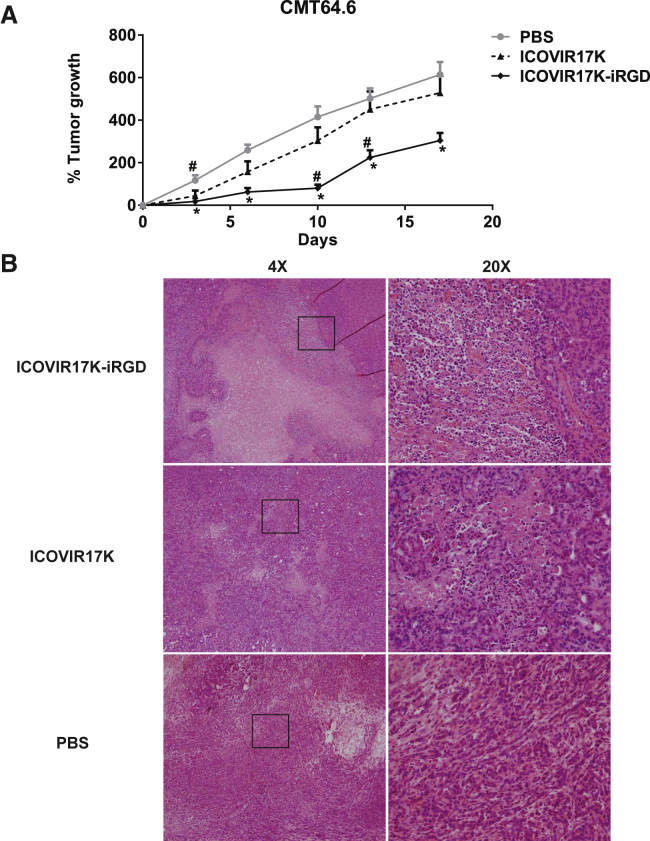
Anti-tumor Efficacy Comparison of ICOVIR17K and ICOVIR17K-iRGD in Immunocompetent MiceC57BL/6 mice bearing CMT64.6 murine lung carcinoma subcutaneous tumors were systemically treated with a single dose of PBS or 3 × 1010/mouse of ICOVIR17K-iRGD or ICOVIR17K. (A) The percentage of tumor growth (mean ± SEM) at the indicated days is plotted (n = 12). Significance (*p < 0.05) against PBS, and significance (#p < 0.05) against ICOVIR17K by two-tailed unpaired Student’s t test. (B) H&E staining for paraffin tumor sections. Nuclei stained in blue correspond to granulocytes.